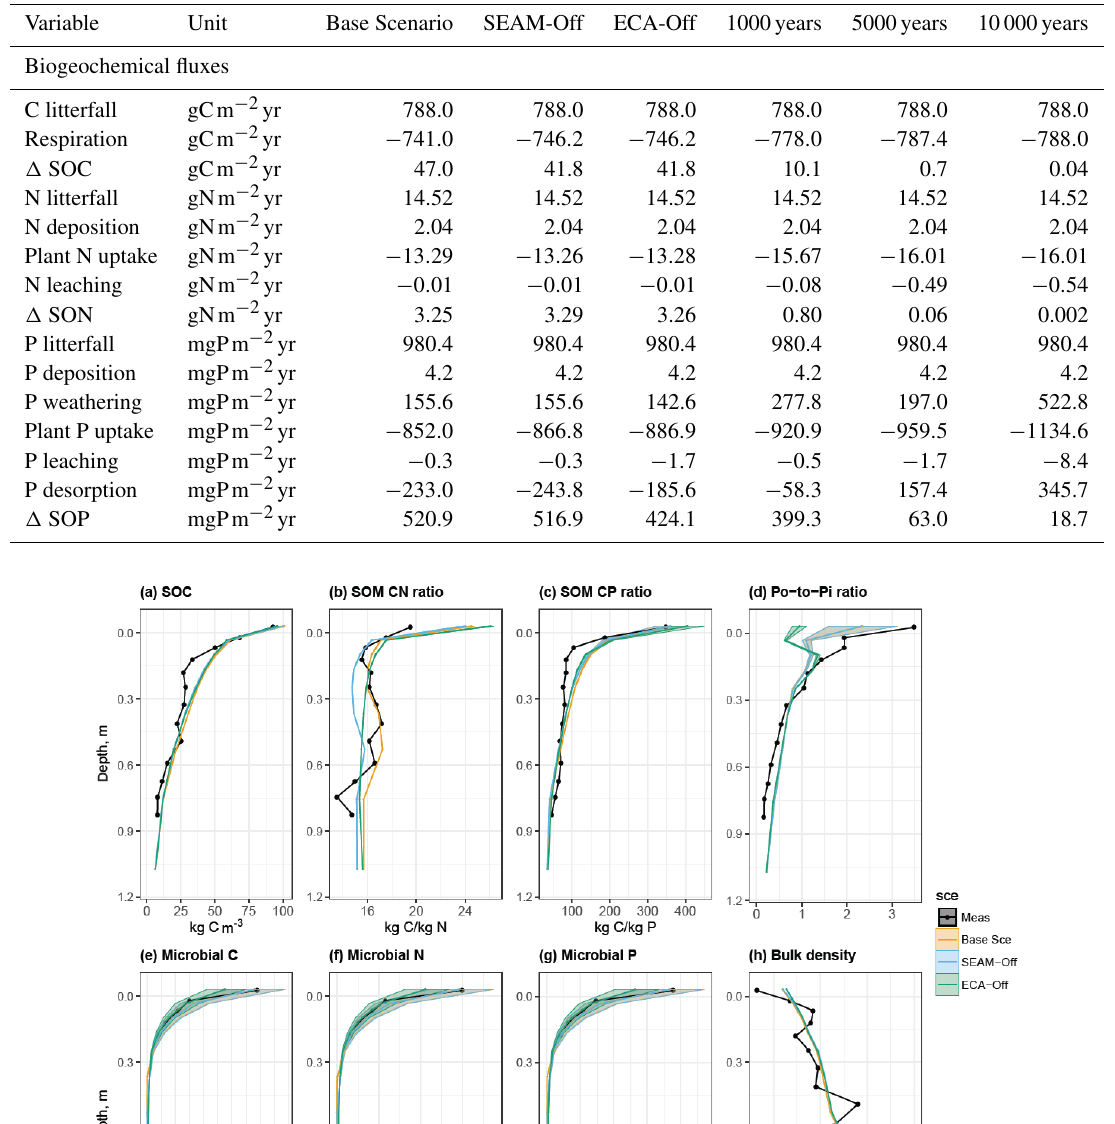
Table 1. The annual soil C, N and P fluxes of model experiments at the study site. Positive values infer accumulation in the soil, and negative values infer loss from the soil. The values are the accumulated sum of the whole soil profile, calculated based on data from the last 10 years of model experiments. SOP: soil organic phosphorus; SON: soil organic nitrogen.